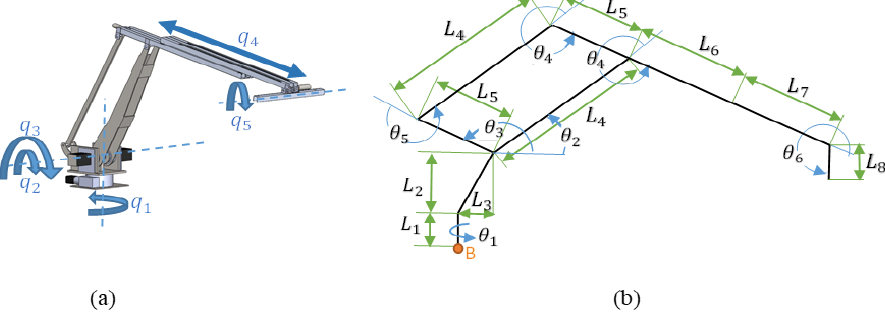
Figure 1. 5-DOF robotic manipulator used here: ( a ) its DOF; ( b ) its angles and lengths.